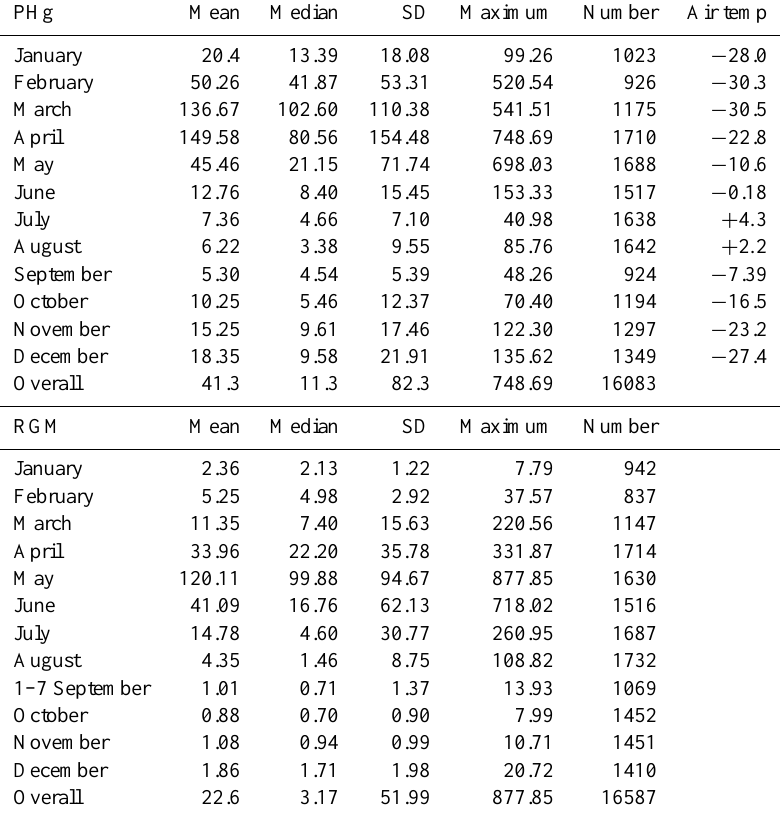
Table 2. Descriptive statistics of [PHg] (top) and [RGM] (bottom) for monthly data and overall data between 2002 and 2011 at Alert, Canada. All concentrations for mean, median, standard deviation (SD) and maximum are reported in pgm − 3 . Number represents the number of data points included in the statistics. Mean monthly air temperature is reported in ◦